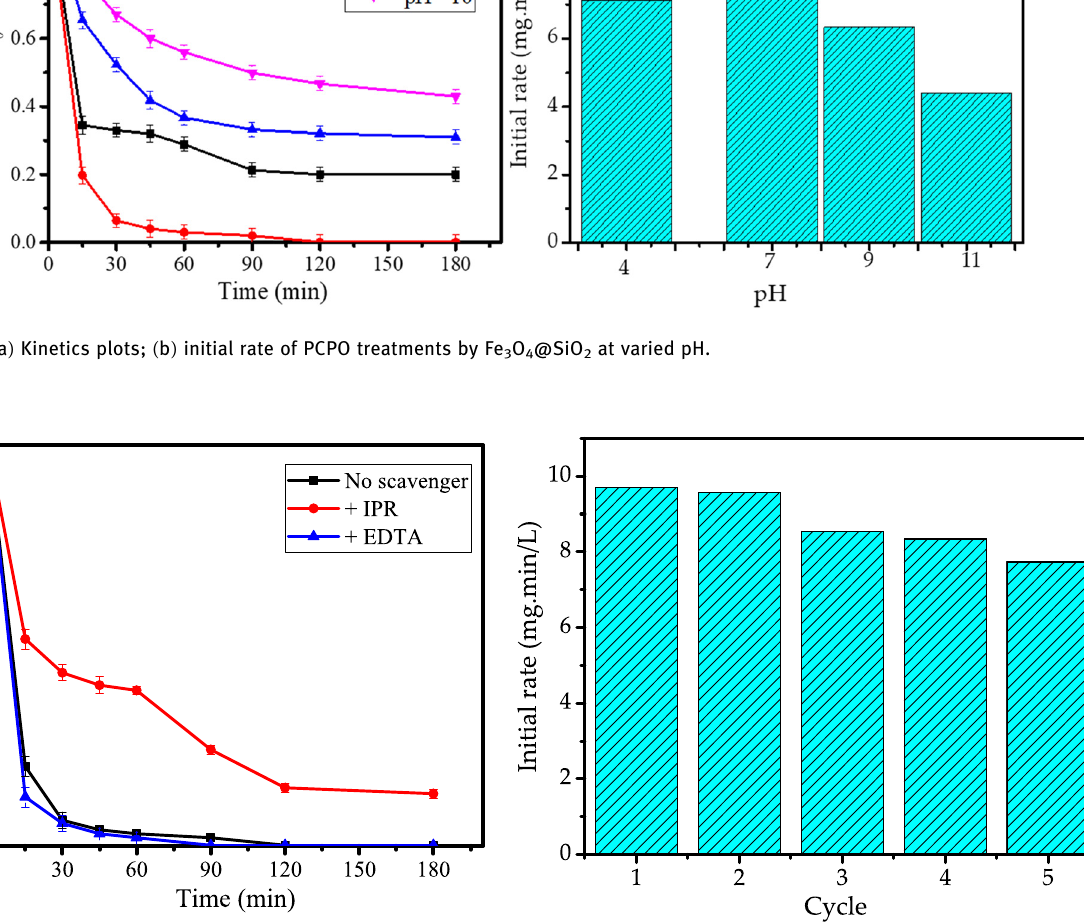
Figure 15: DE of PCPO process using Fe 3 O 4 @SiO 2 at fi rst – fi fth